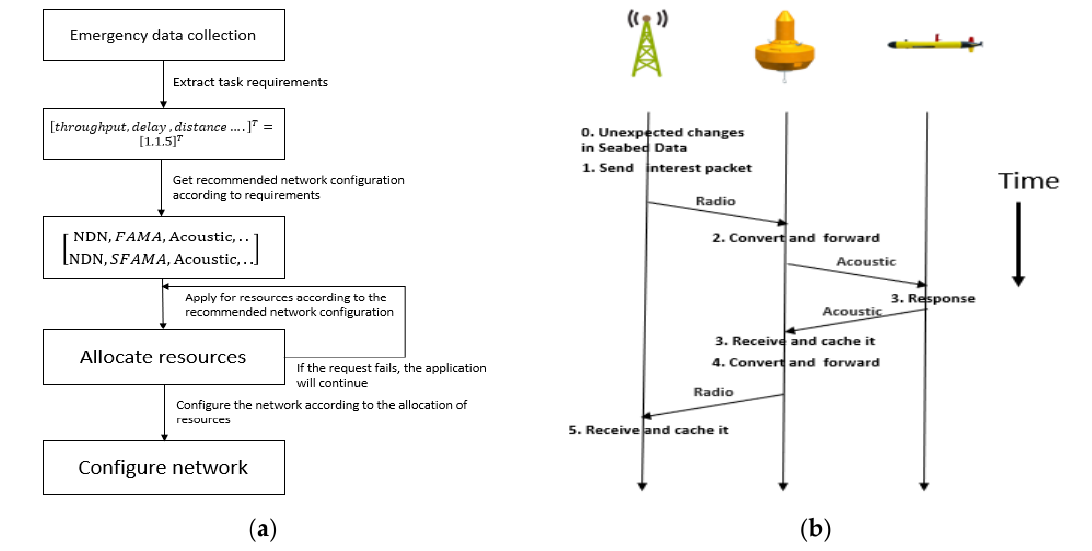
Figure 17. ( a ) Data collection application emergency network resource request; ( b ) detailed information of interaction between terminals of the underwater data collection network emergency task.